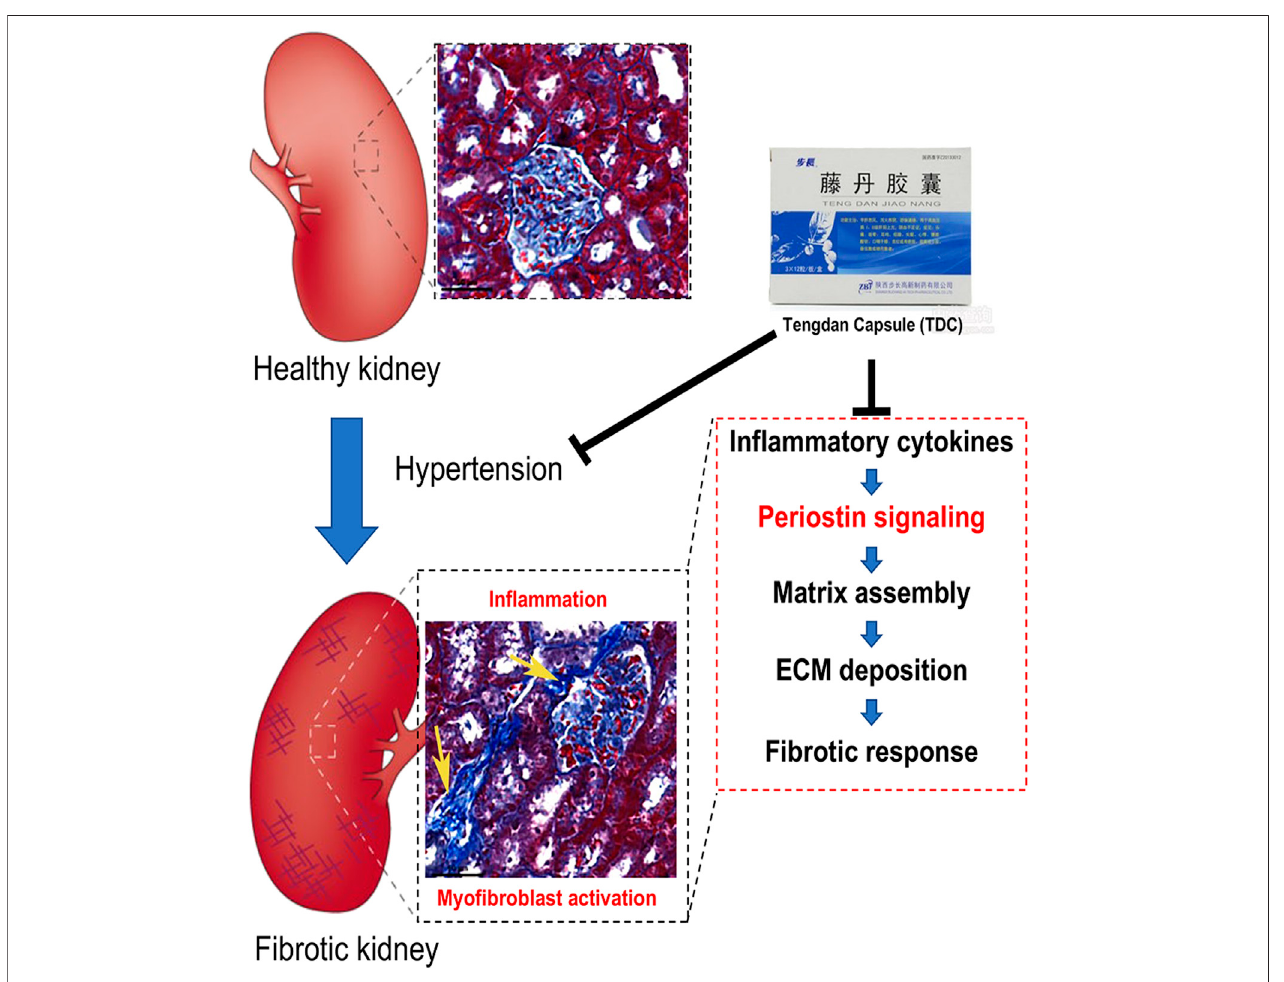
FIGURE9| SchematicdiagramofhowTengdanCapsule(TDC)preventsprogressionofhypertensiverenaldamage via periostin-mediatedpathway.Hypertension causes renal in fl ammation and myo fi broblast activation. Different cytokines and growth factors upregulate periostin expression. Periostin interacts with its integrin receptors on thecell surface,inducingin fl ammationand matrix assembly and promotingcell adhesion, migration, and proliferation. TDC reduces blood pressureas well as blocks these pathways that amplify the in fl ammatory and fi brotic responses.